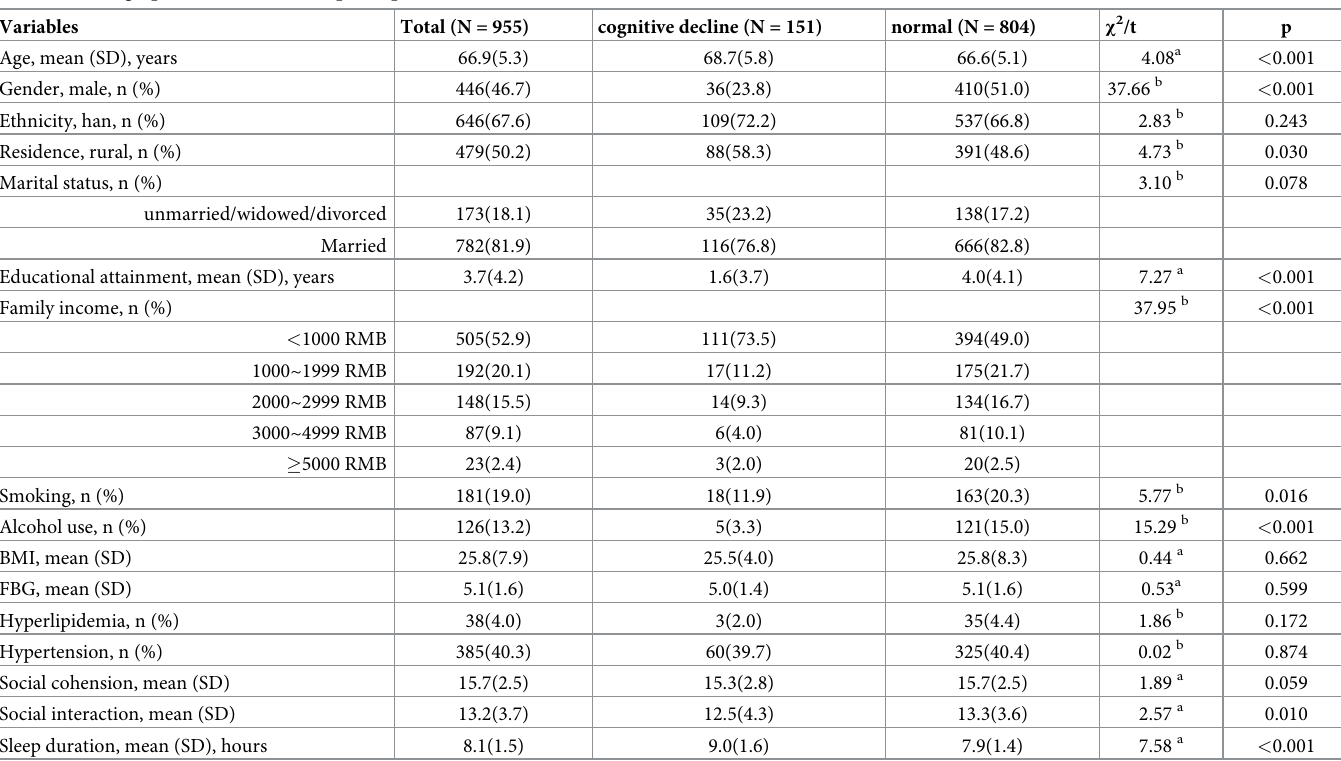
Table 1. Demographic characteristics of participants (n = 955).